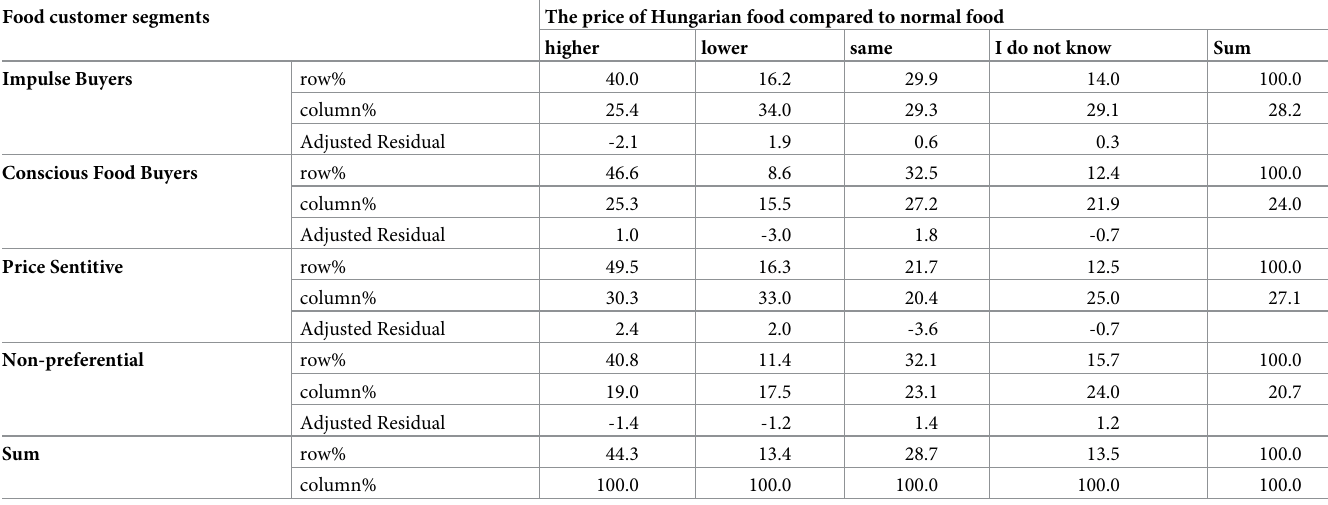
Table 6. Opinion of food customer segments on the price of Hungarian food. Food customer